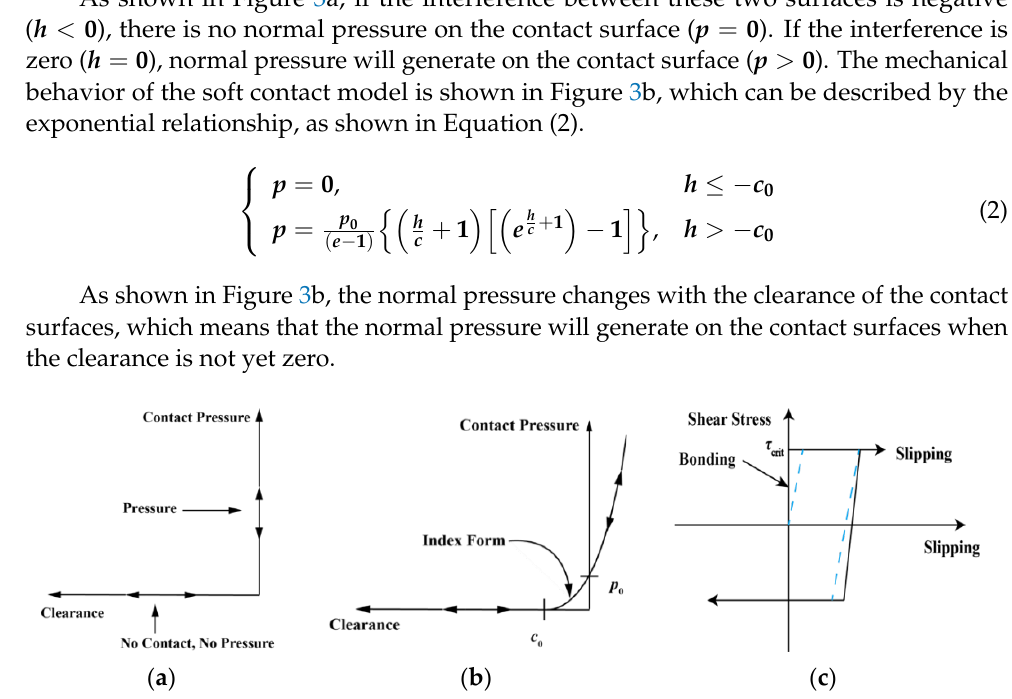
Figure 3. Mechanical behavior of different contact models, where ( a ) is the hard contact model in normal contact model, ( b ) is the soft contact model in normal contact model, and ( c ) is the tangential contact model .